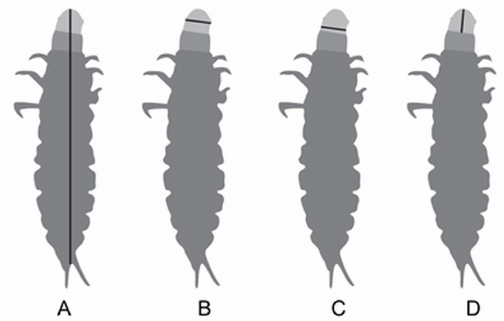
Figure 1. Black lines illustrate the measured body parts for Leptonema larvae. (A) body length, (B) interocular distance, (C) horizontal width of the cephalic capsule, and (D) vertical width of the cephalic